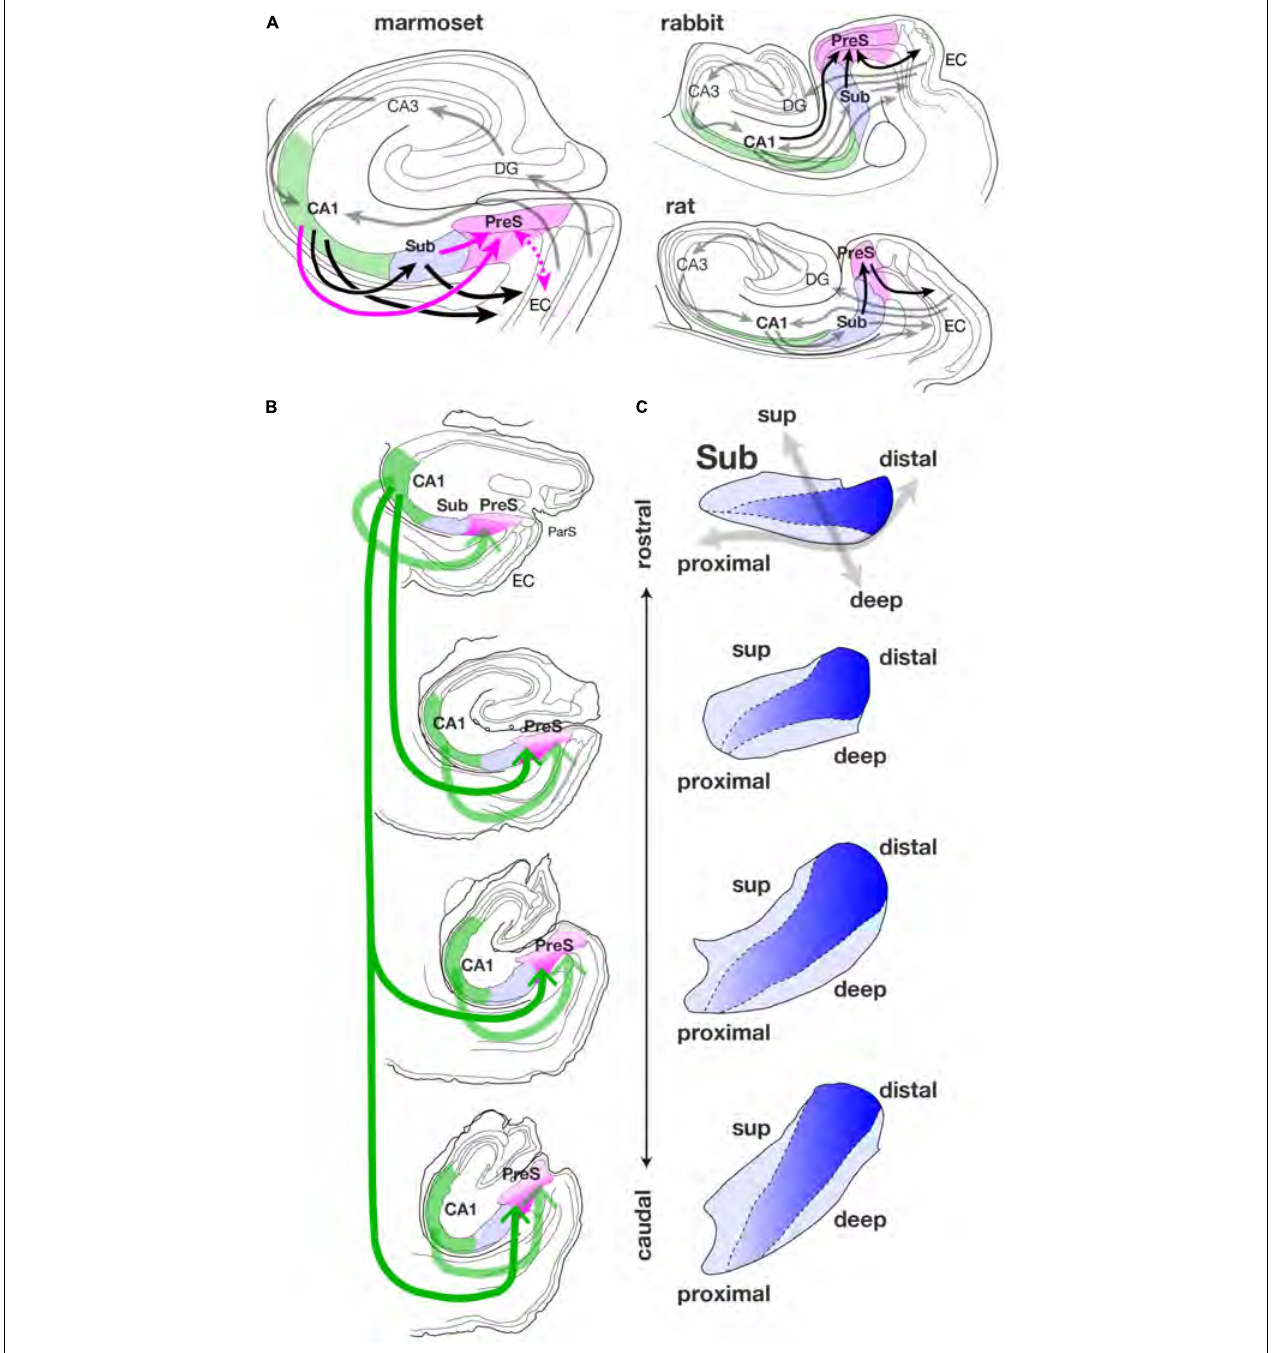
FIGURE 9 | (A) Summary diagrams of connections among the hippocampal and parahippocampal areas of the marmoset, rabbit, and rat. In the diagram of the marmoset, magenta arrows indicate projections that were found by our studies. A dotted magenta arrow represents the bidirectional connections between PreS and EC which is currently under investigation. Black allows along with the solid magenta arrows indicate back pathways from CA1 (green-filled area) to EC via Sub (blue-filled area) and/or PreS (magenta-filled area). Gray arrows represent the hippocampal afferents originating from EC and information flow between DG and CA regions, that are conserved from rodents to primates. In the diagrams of rabbit and rat, gray arrows indicate the information flow between EC and the hippocampal formation, and black arrows indicate indirect hippocampal-entorhinal back pathways via PreS. To avoid complication, the projections from EC to CA3 and from EC to Sub are not displayed in these diagrams. (B) Schematic diagram showing the spread of CA1-PreS projection along the longitudinal (rostrocaudal) axis of the hippocampal formation. The thickness of green arrow indicates the amount of projection, and the dark magenta area of PreS represents high density of terminal distribution. (C) Schematic representation of the localization of PreS projection cells in the pyramidal cell layer of Sub along the longitudinal (rostrocaudal) axis. Blue gradient indicates the population density of PreS projection cells along the proximodistal axis. Note that the dark blue region is distributed in the middle superficial-to-deep part of the distal half of